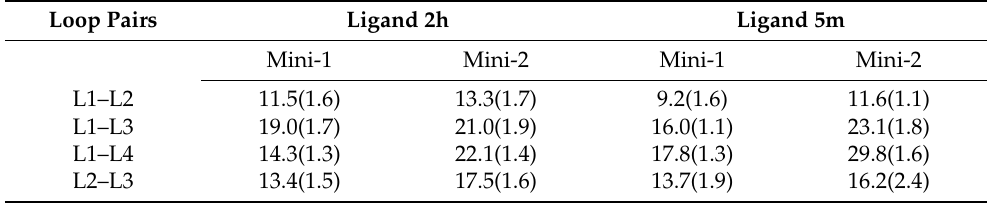
Table 1. The minimal average distance between the pair loops (L1, L2, L3, and L4), which correspond to the binding cavity, for the last 3 ns of the MD trajectory of respective